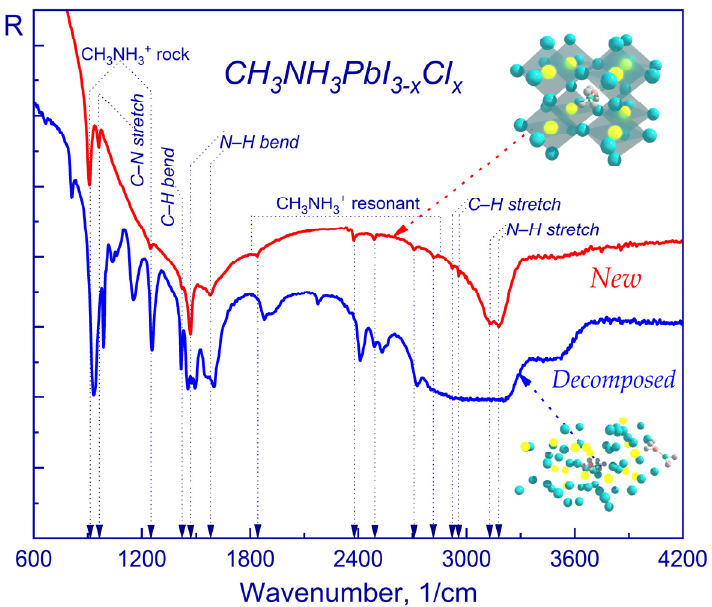
Figure 1. Fourier transform IR spectra of CH 3 NH 3 PbI 3-x Cl x single crystal samples: freshly prepared (red) perovskite thin film and exposed to atmosphere (blue).